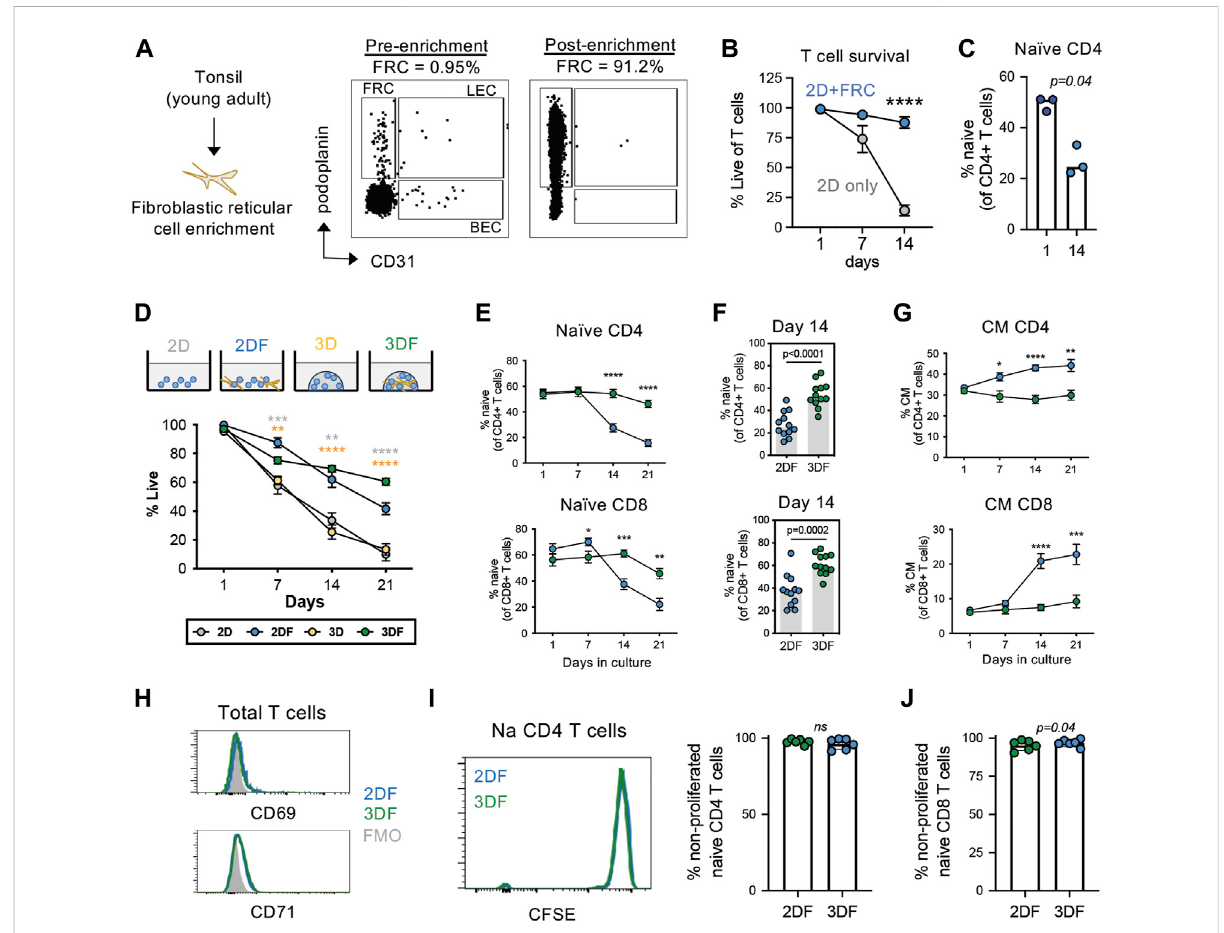
FIGURE 1 Naïve T cells are maintained in a resting state in SLT-like organoids. (A) Enrichment of FRCs (CD45 neg CD31 neg podoplanin + ) from tonsil tissue of youngadults. (B) ViabilityoftotalTcellsand (C) frequencyofnaïve(CD45RA+CCR7+)CD4Tcellsin2DcultureconditionswithandwithoutFRCco- culture (mean± SEM). ( n = 3) (D) Frequencies of live T cells based on viability dye over time across all culture conditions. (E) Frequencies of naïve CD4 and CD8 T cells ( n = 12) over time across 2DF and 3DF conditions. Mean ± sem. p -values compare 2DF vs. 3DF within one time point. (F) Frequencies of naïve (CD45RA + CCR7+) CD4 and CD8 T cells at day 14 in 2DF versus 3DF conditions. ( n = 12) (G) Frequencies of central memory (CD45RA-CCR7+) CD4 and CD8 T cells ( n = 12) over time across 2DF and 3DF conditions. Mean ± sem. (H) Expression of activation markers CD69 and CD71 on naïve CD4 T cells at day 14, representative of three individual donors. (I,J) CFSE proliferation analysis of (I) naïve CD4 T cells and (J) naïve CD8 Tcells at day14 ( n = 6 young donors,paired).* p < 0.05, ** p < 0.01, *** p < 0.001, **** p < 0.0001. p -values determined by paired t